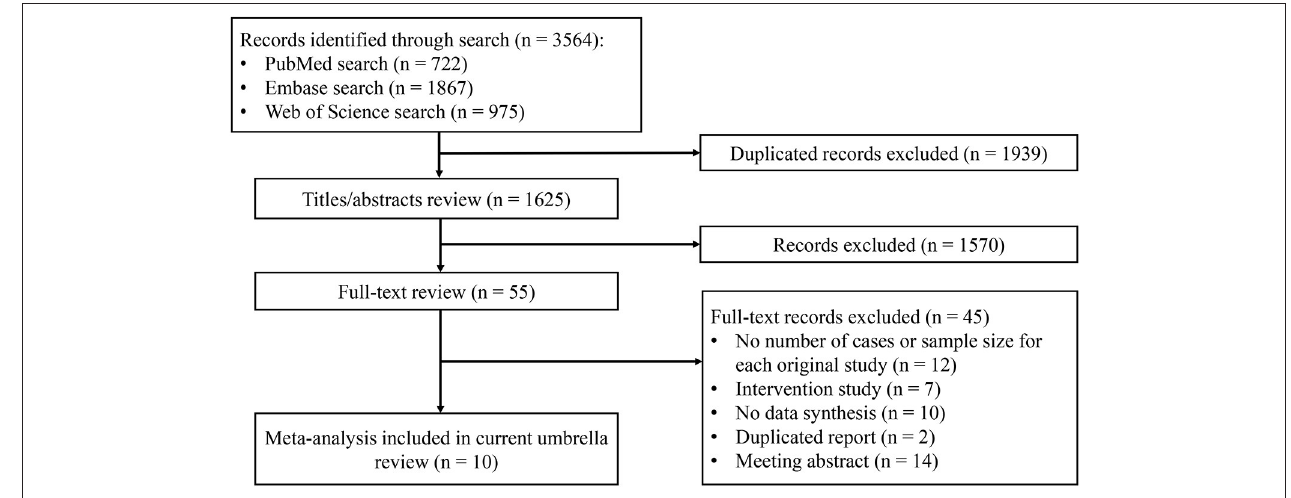
FIGURE 1 | Flowchart of selection of meta-analyses for inclusion in umbrella